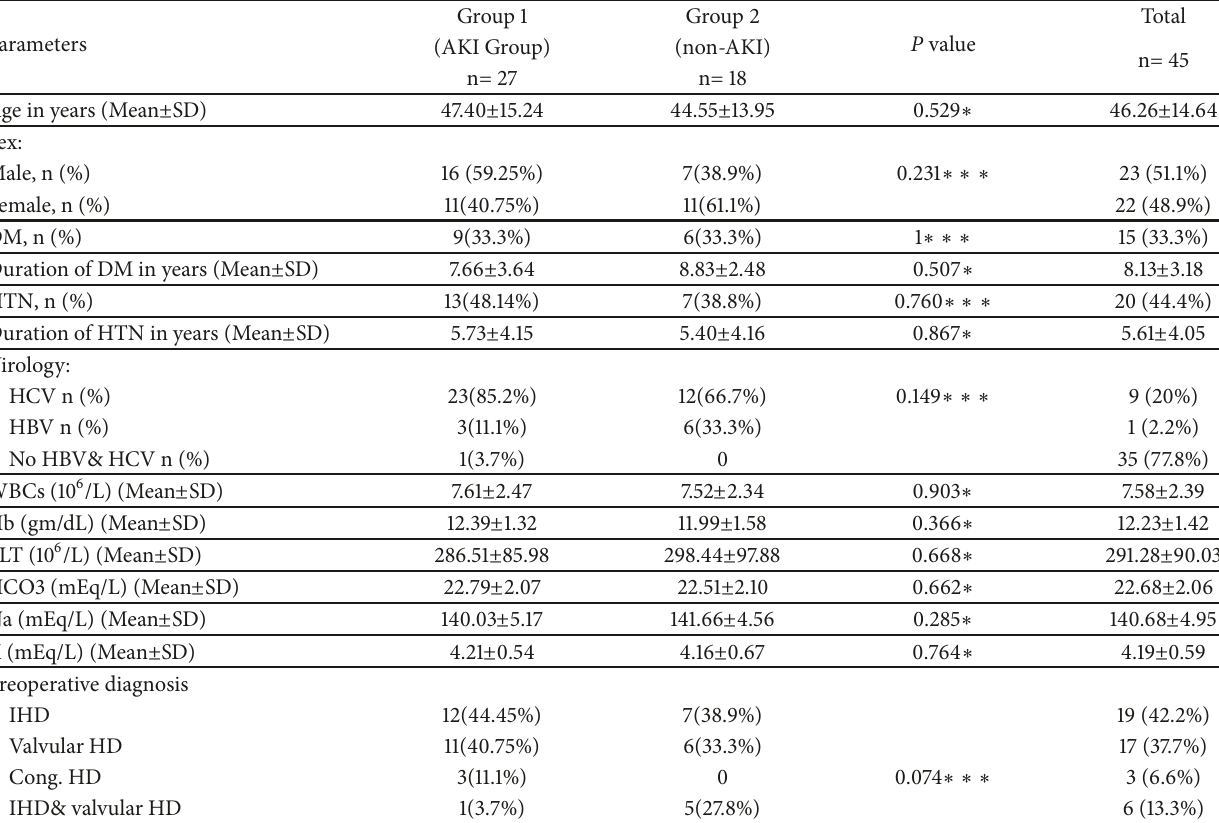
Table 1: Preoperative demographic, laboratory data, and indications of surgery of studied patients (n = 45).